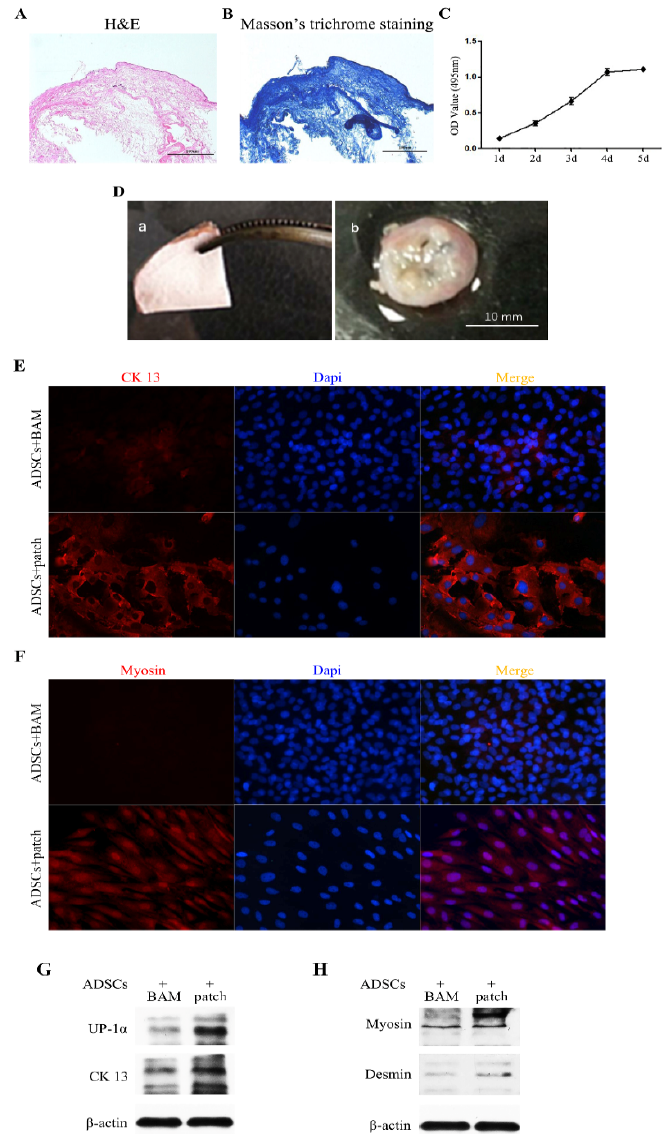
Figure 2. The surgical patch preparation and effect of ADSCs. ( A , B ) H&E and Masson’s trichrome staining showed almost no residual host-porcine cells. ( C ) CCK8 assay ADSCs proliferation on the surgical patch in five consecutive days. ( D ) Morphological features of the jelly-like patch. ( left ) Before graft patch. ( right ) Patch in the rat bladder at 2nd week after surgery. ( E ) CK13 immunostaining of ADSCs encapsuled by surgical patch or BAM. ( F ) Myosin immunostaining of ADSCs encapsuled by surgical patch or BAM. ( G ) Western blot results indicated the expression of UP-1 α and CK13 in ADSCs encapsuled by surgical patch or BAM. ( H ) Western blot results indicated the expression of myosin and desmin in ADSCs encapsuled by surgical patch or BAM.